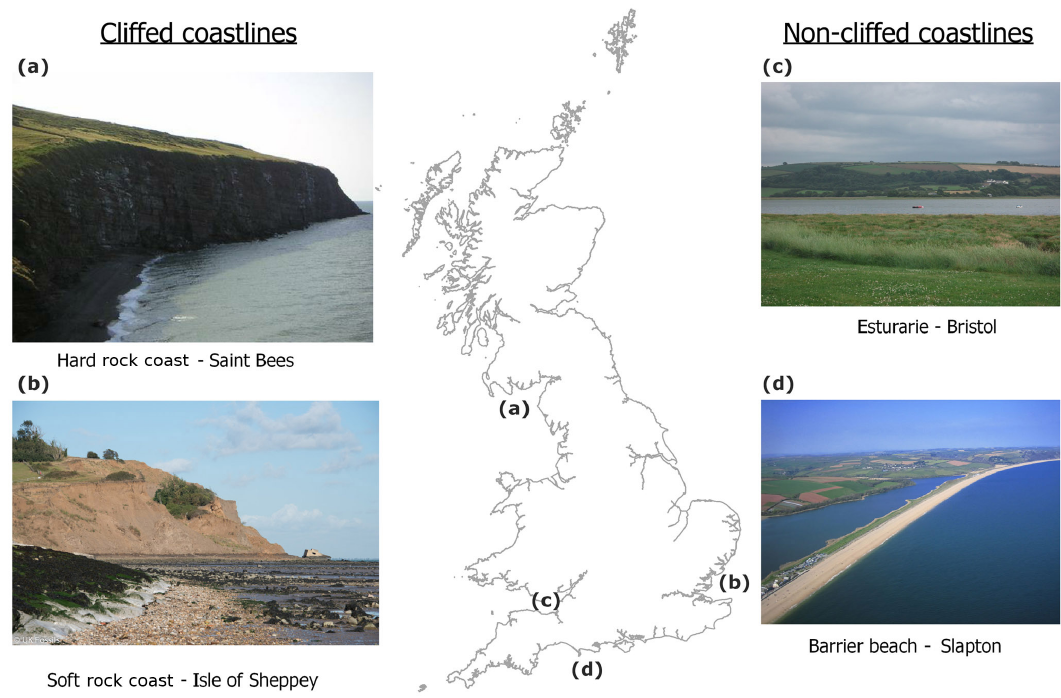
Figure 1. The problem of defining the top and bottom of a cliff is not trivial. For example, most of Britain’s coastline is made of cliffs (hard and soft) but also beaches and estuarine environments. (a) Cliff top and toe are readily apparent for the hard rock coast of Saint Bees but not as clear at the soft-cliffed coastline of the Isle of Sheppey where landslides are ubiquitous (b) . Cliffed coastlines are often interrupted by other landforms such as estuaries (c) and beaches (d)